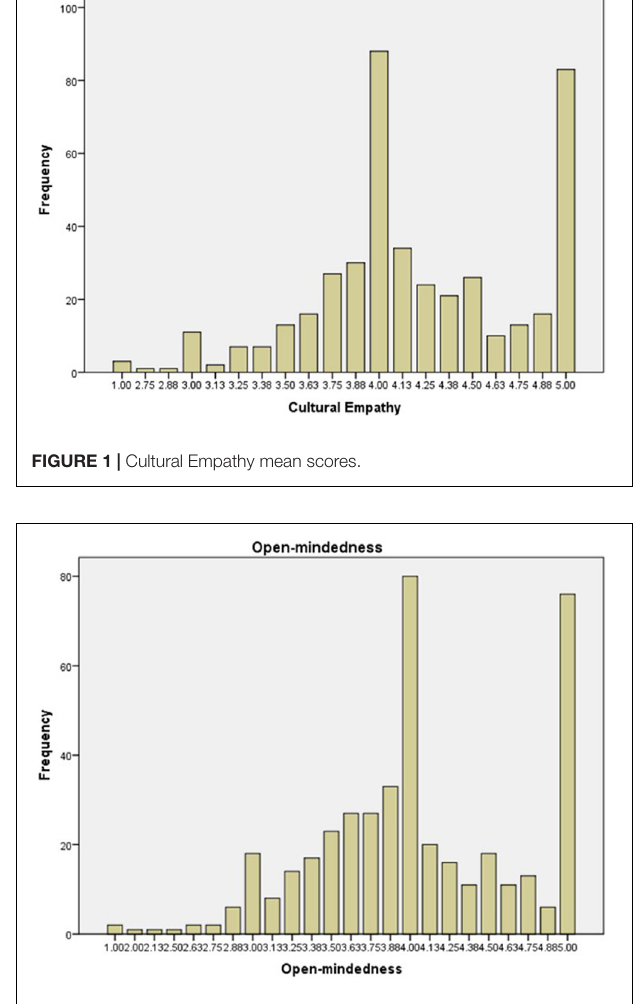
FIGURE 2 | Open-mindedness mean